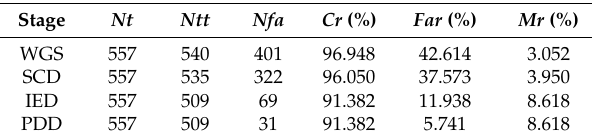
Table 2. Effectiveness of the main stages in the proposed